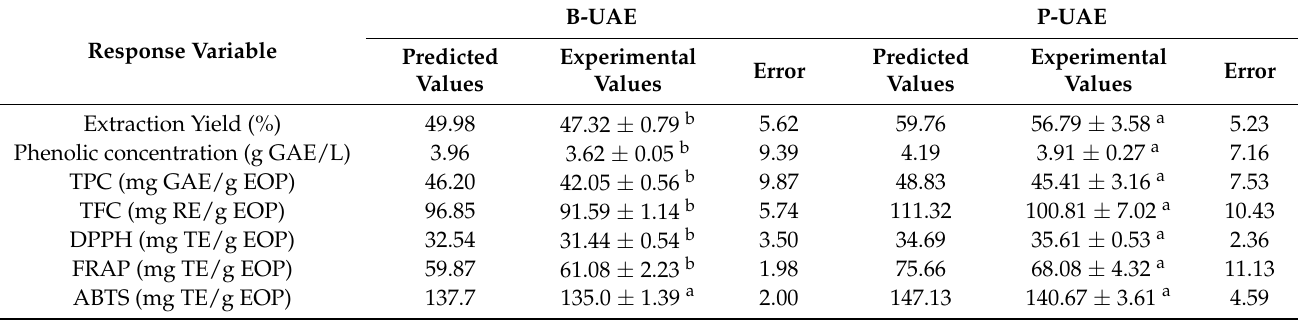
Table 5. Predicted and experimental values obtained by bath- (B) and probe (P)-ultrasound-assisted extraction (UAE) for exhausted olive pomace (EOP) under the optimal conditions, which simultaneously maximized the seven responses. Data represent the average value and standard deviation (n =